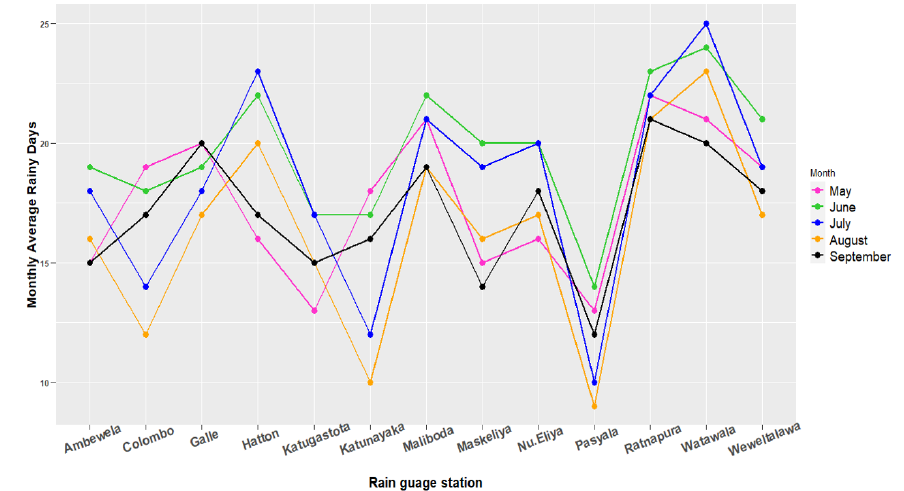
Figure 2: Monthly average rainy days for 13 rain gauge stations during 1981 - 2010.